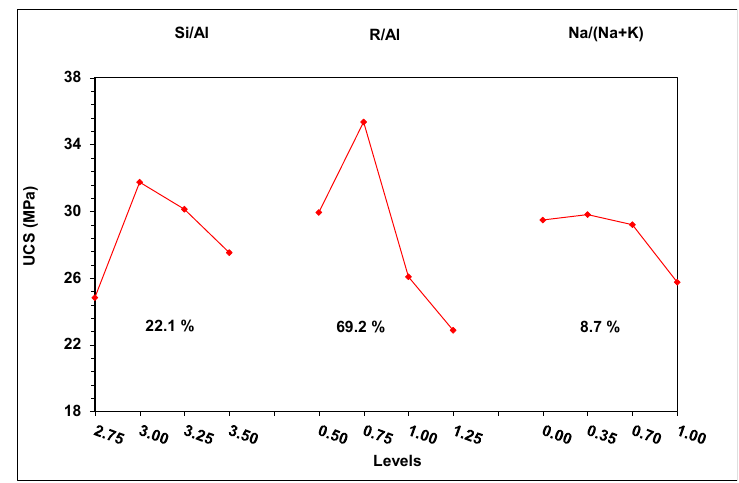
Figure 3. Effect of the studied factors on the development of compressive strength.